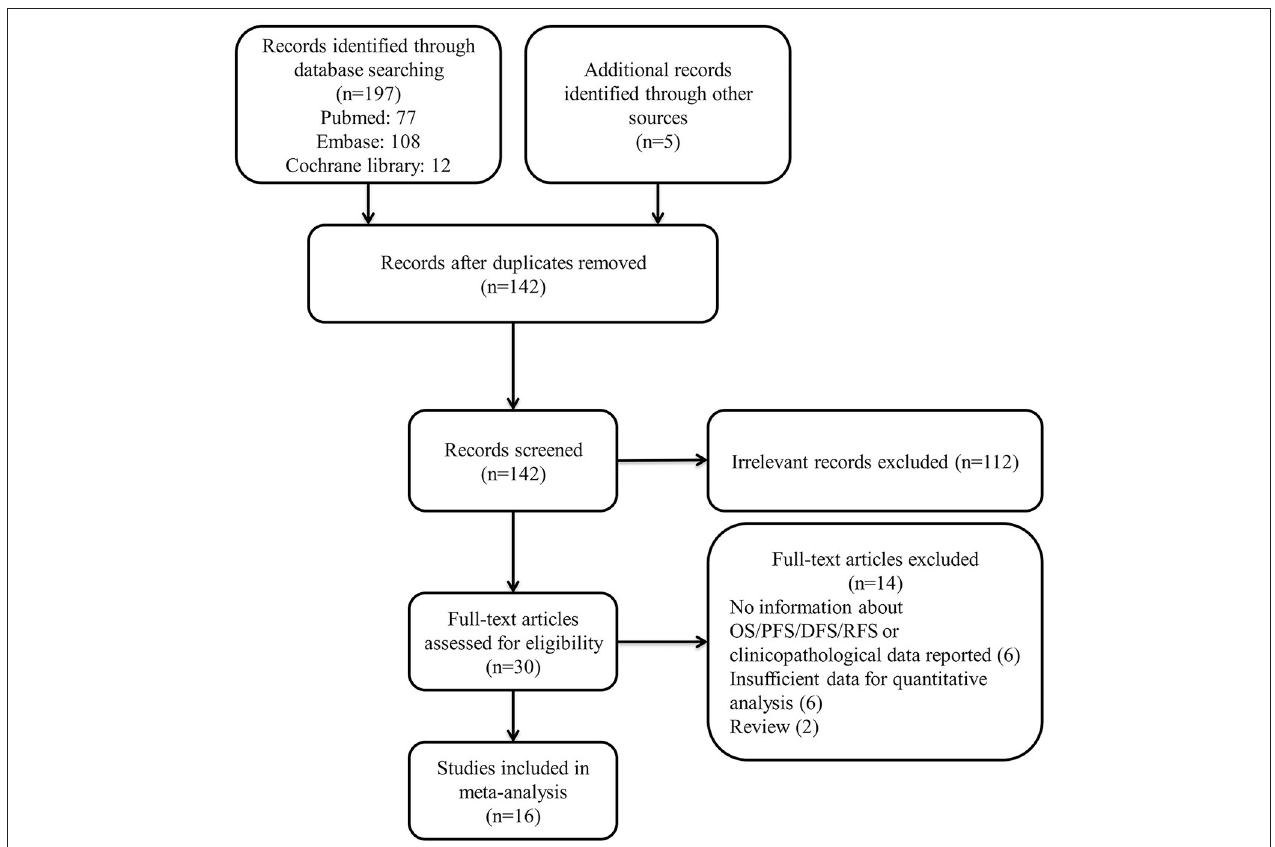
FIGURE 1 | Flow chart of the study screening